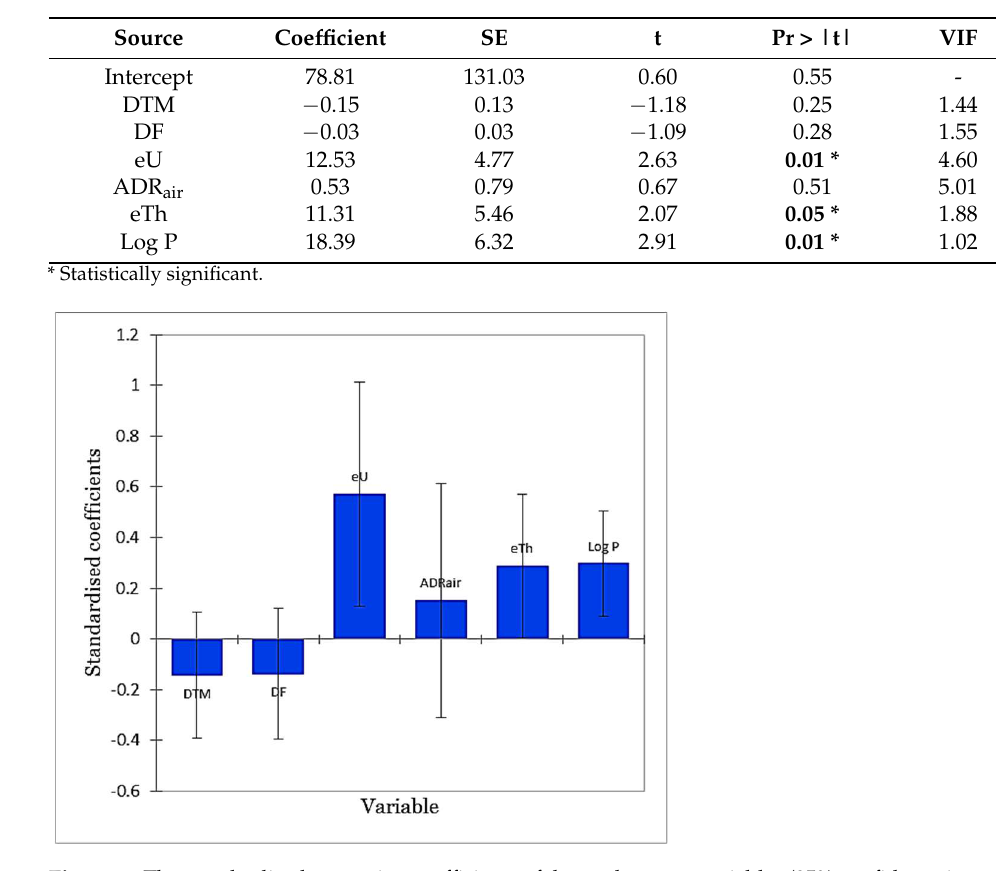
Table 2. Main statistics of the coefficients of the explanatory variables for the OLS model.